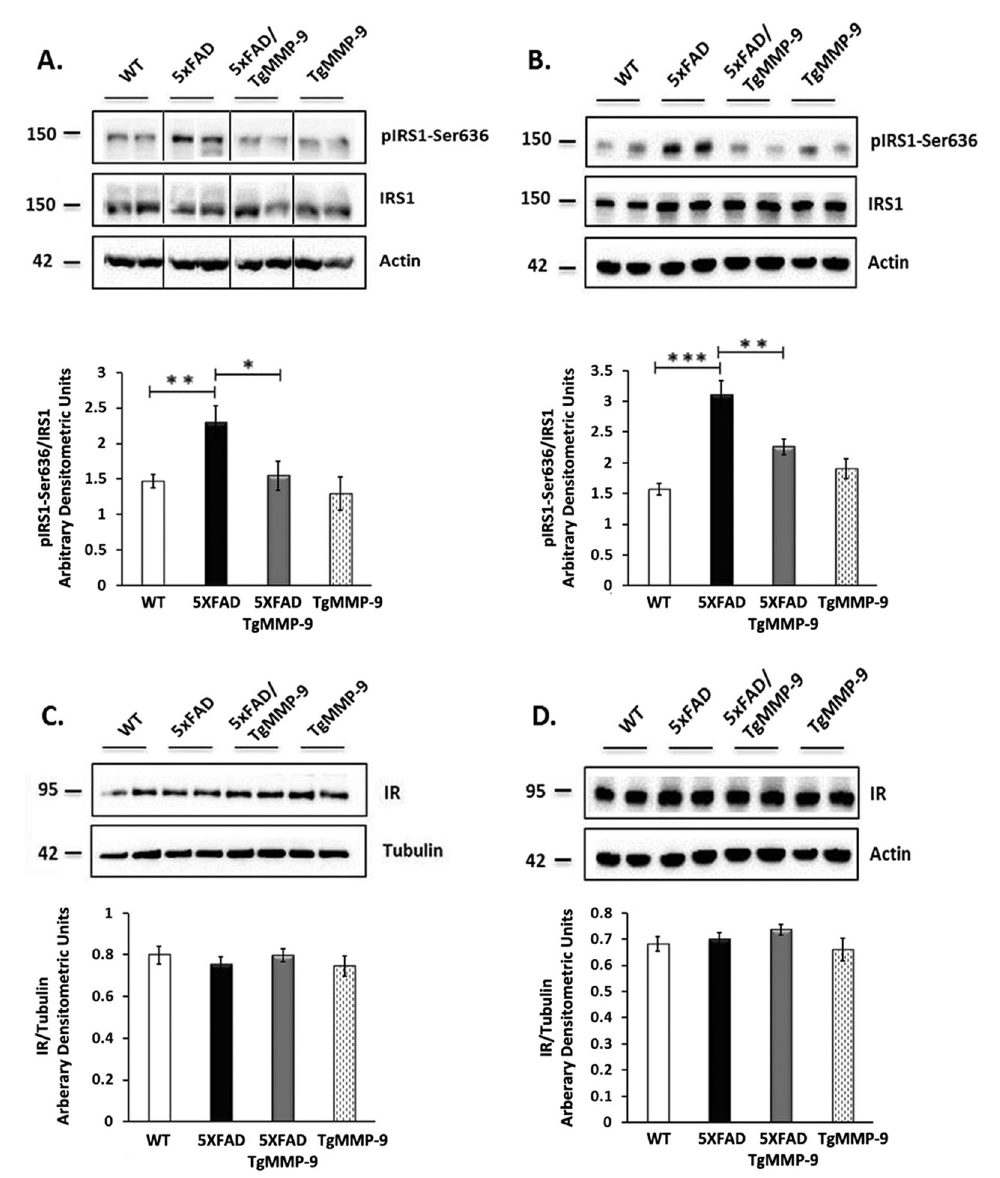
Figure 1. Representative Western blots of protein samples from primary hippocampal cell lysates ( A , C ) and hippocampal homogenates from 3 month-old mice ( B , D ) of WT, 5XFAD, 5XFAD/TgMMP-9 and TgMMP-9 mice. Equal amounts of total protein were analysed on 7.5% SDS-PAGE gels and immunoblotted with primary antibodies against pIRS1-Ser636, IRS1 and IR. To ensure equal loading, membranes were re-probed against β -Tubulin or β -Actin. Graphs depict densitometric quantification of phosphorylated proteins normalized to their respective total protein levels and total protein levels to their housekeeping gene. n = 8–12 ( A ), n = 11–14 ( C ), n = 7–10 ( B ), n = 5–12 ( D ). All data are presented as mean ± SEM ( * p < 0.05, ** p < 0.01, *** p < 0.001). Lanes were run on the same gel but were noncontiguous. Full-length images are presented in the Supplementary